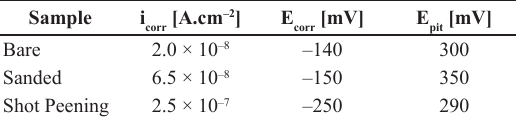
Table 3. Results obtained by polarization curves and Tafel extrapolation.